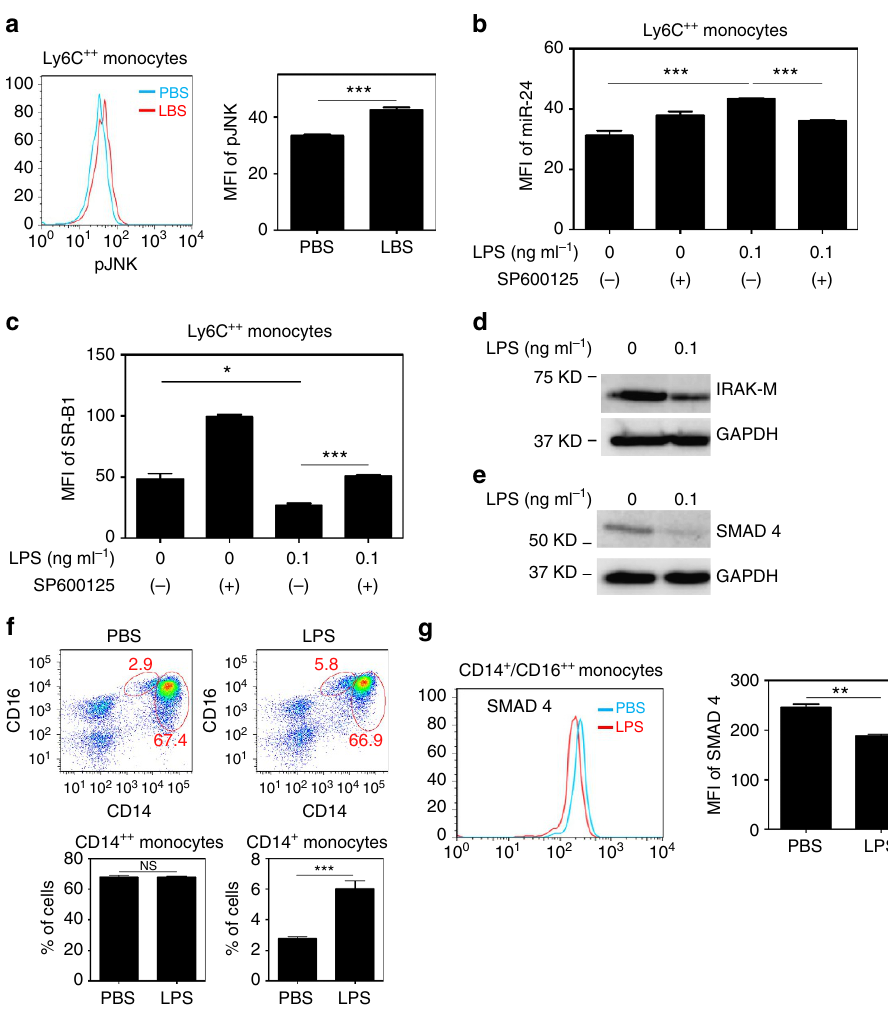
Figure 5 | Polarization of low-grade inflammatory monocytes through the reduction of IRAK-M. ( a – e ) BMMs from C57 BL/6 mice were cultured with M-CSF (10ngml (cid:2) 1 ) in the presence LPS for 5 days and SP600125 was added to some cultures. Fresh LPS and SP600125 was added every 2 days. ( a ) JNK phosphorylation within CD11b þ Ly6C þ þ monocytes treated with super-low-dose LPS (0.1ngml (cid:2) 1 ) was determined by flow cytometry. ( b ) Fluorescent RNA probe for miR-24-3p was added to the cell cultures 16h before harvesting. The expression levels of miR-24-3p within CD11b þ Ly6C þ þ monocytes were examined by flow cytometry. ( c ) The expression levels of SR-B1 within CD11b þ Ly6C þ þ monocytes were examined by flow cytometry. ( d , e ) Western blot analyses of SMAD4 and IRAK-M expression in the cell cultures. ( f , g ) Peripheral blood mononuclear cells collected from healthy individuals were cultured with M-CSF (100ngml (cid:2) 1 ) in the presence super-low-dose LPS (5pgml (cid:2) 1 ) for 2 days. The frequency of inflammatory monocytes ( f ) and SMAD4 expression within CD14 þ CD16 þ population ( g ) was determined by flow cytometry. Quantified data are shown from cells with indicated treatment ( n ¼ 3) and results are representative of three experiments. Error bars show means ± s.e.m.; NS, not significant; * P o 0.05, ** P o 0.01 and ***, P o 0.001; ( a , f , g ) Student’s t -test; ( b ) one-way analysis of